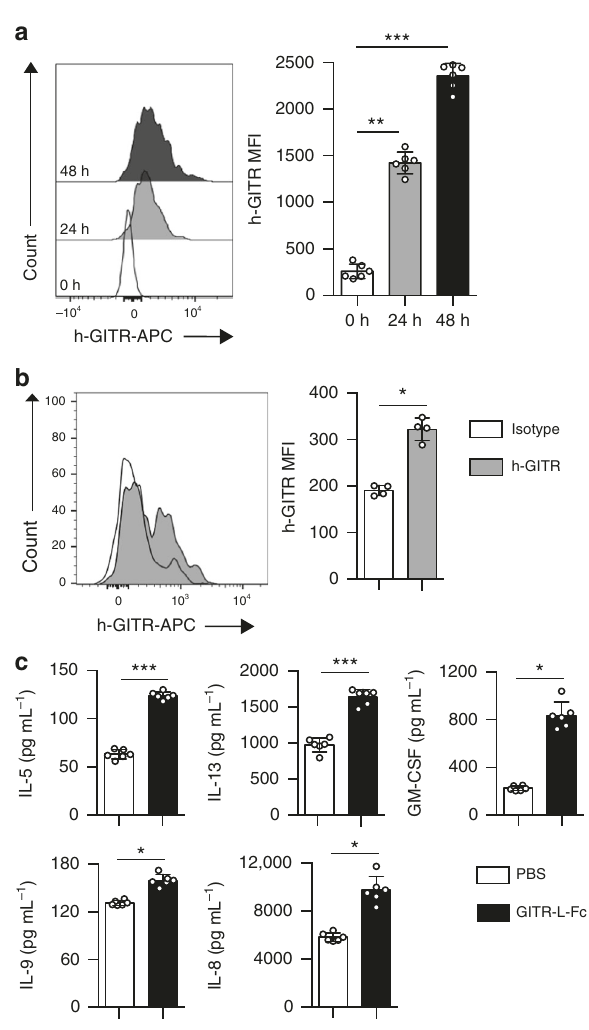
Fig. 8 GITR is expressed on human ILC2s and augments Th2 cytokine production. FACS-sorted human blood ILC2s were cultured with recombinant human (rh) IL-2, rhIL-7, and rhIL-33 and plate bound GITR- L-Fc or isotype control, human IgG, n = 6. a Representative FACS plots of h- GITR expression after 0, 24, and 48 h of stimulation on ILC2s and corresponding quantitation presented as MFI. b Representative FACS plot of h-GITR staining on VAT-ILC2s isolated from healthy subjects and corresponding quantitation, n = 4. c The levels of IL-5, IL-13, GM-CSF, IL-8, and IL-9 in the culture supernatants were measured by Luminex after 24 h of stimulation. Data representative of 6 individual blood donors, n = 6. Error bars are the mean ± SEM. Student ’ s t -test, * p < 0.05, ** p < 0.01, *** p <